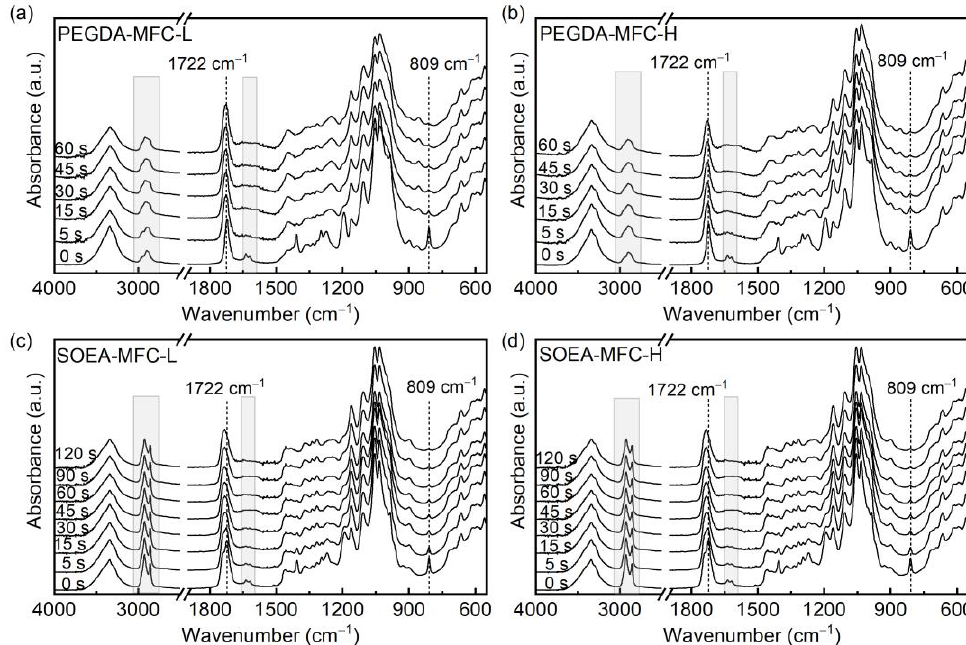
Figure 4. FTIR spectra of composites before and after given irradiation times: ( a ) PEGDA-MFC-L, ( b ) PEGDA-MFC-H, ( c ) SOEA-MFC-L, and ( d ) SOEA-MFC-H.